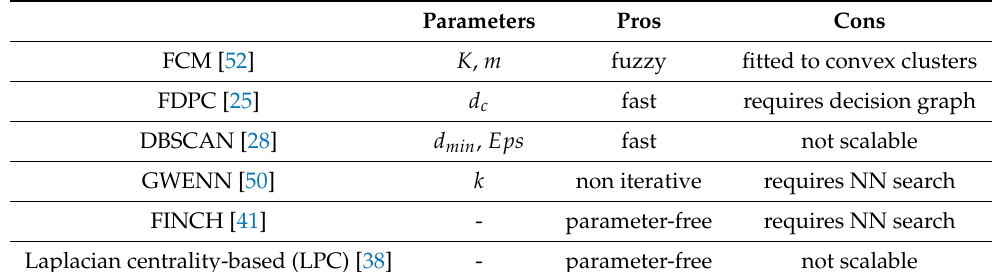
Table 2. Characteristics of the clustering methods used for comparison to this